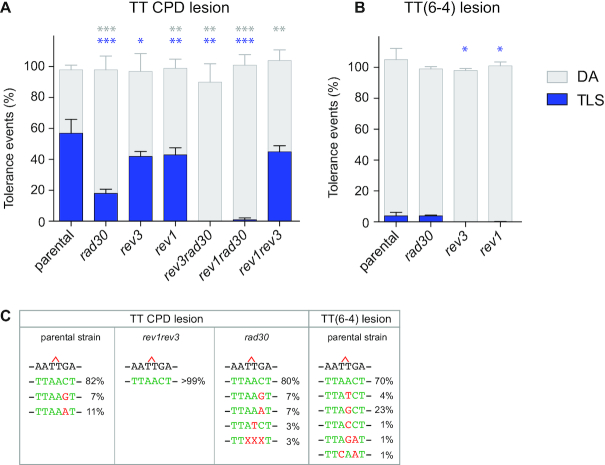
Partitioning of DDT pathways in a strain deficient in TLS polymerases. The graphs represent the partition of DDT pathways for two UV lesions, in strains deficient in TLS polymerases (Rev1, Pol η/rad30, Pol ζ/rev3). Tolerance events represent the percentage of cells able to survive in presence of the integrated lesion compared to the lesion-free control. The data represent the average and standard deviation of at least three independent experiments in which the lesion has been inserted either in the leading or the lagging strand. Unpaired t-test was performed to compare TLS and DA values from the different mutants to the parental strain. *P < 0.05; **P < 0.005; ***P < 0.0005. All strains are phr1Δ rad14Δ msh2Δ::hisG. (A) In a parental strain over 50% of events observed across a CPD lesion are TLS events. DNA polymerase η is responsible for the majority of CPD lesion bypass. However, in its absence TLS bypass of this lesion is still possible through the combined action of polymerase ζ and Rev1. In the absence of pol η, removal of either Rev1 or pol ζ completely abolishes TLS. (B) For the TT(6-4) lesion, DA is the major tolerance pathway. Majority of TLS events through TT(6-4) lesion depend on pol ζ and Rev1, while pol η rarely contributes to the bypass of this lesion. (C) Nucleotides inserted opposite the CPD and TT(6-4) lesions in the different mutants of polymerases. Error-free and mutagenic insertions are represented in green and red respectively. A more detailed mutagenesis spectrum is provided in Supplementary Table S2.